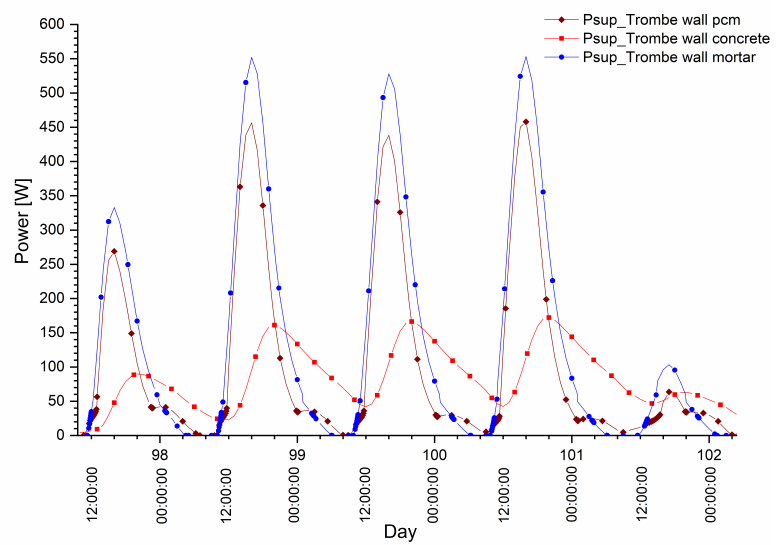
Figure 15. Comparison of power supplied from the solar Trombe wall both with and without phase change materials (PCM).